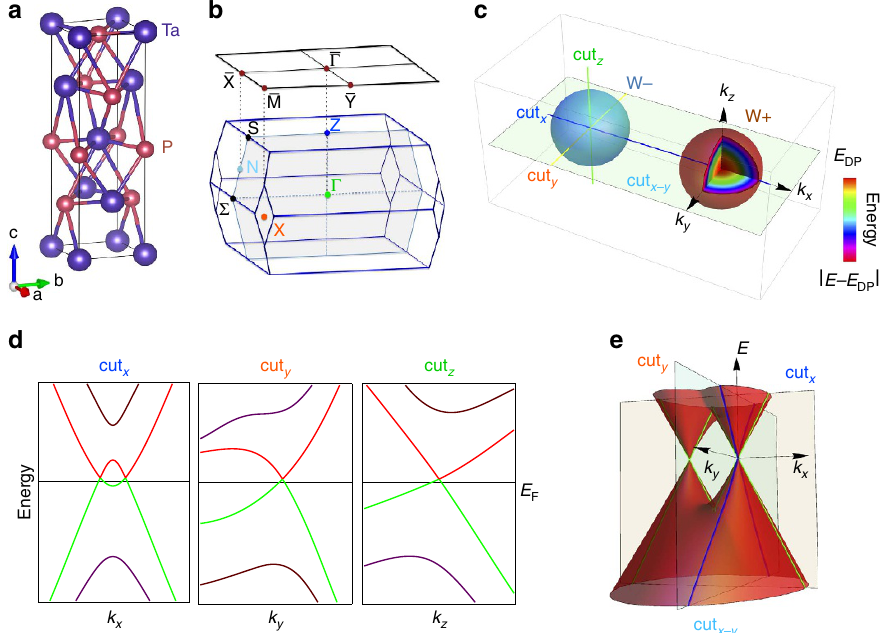
Figure 1 | Pairs of Weyl nodes in TaP. ( a ) Crystal structure of TaP. ( b ) Bulk and surface BZ of TaP with high-symmetry points labelled. ( c ) Illustration of a pair of Weyl nodes in 3D momentum space. ( d ) Band structure passing through Weyl node along cut x , cut y and cut z . ( e ) Schematic band dispersions of a pair of Weyl nodes in the k x - k y plane of the momentum